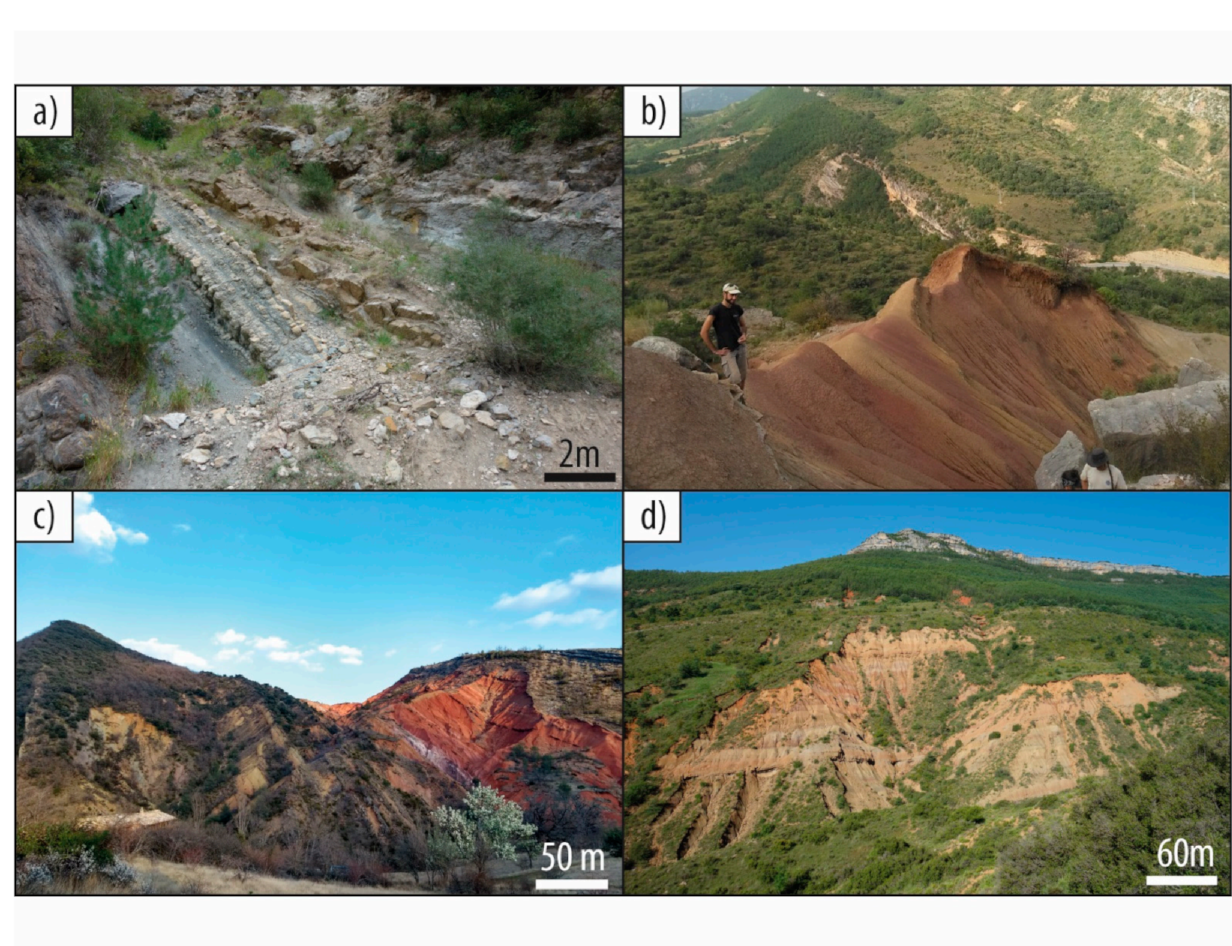
Figure 3. Upper Maastrichtian outcrops of the Western Tremp Syncline (Arag ó n, NE Spain). ( a ) Campo section (I); ( b ) Serraduy section (IV); ( c ) Iscl é s section (VI); ( d ) Ar é n/Areny section